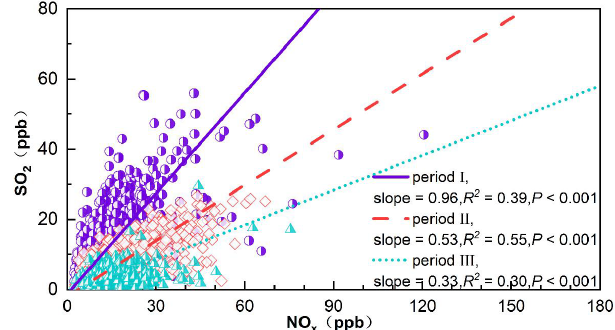
Figure 10. Reduced major axis regressions on the scatter plots of daily average SO 2 and NO x mixing ratios during three periods at